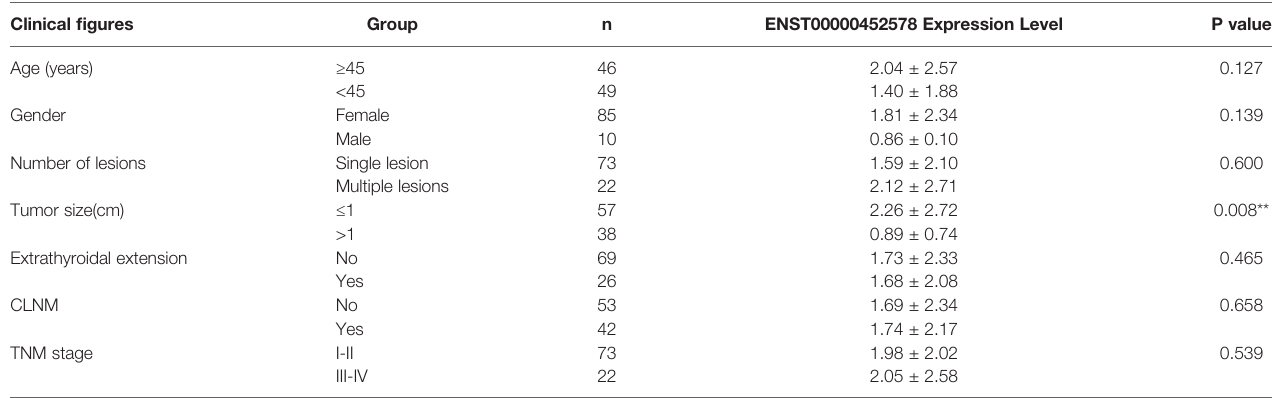
TABLE 3 | Relationship between expression level of lncRNA ENST00000452578 and clinical features. Clinical fi